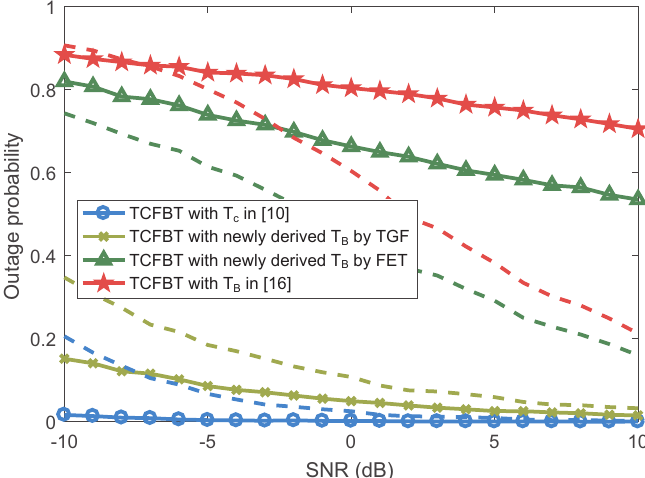
Figure 8. The outage probability vs. SNR with v = 1m/s.